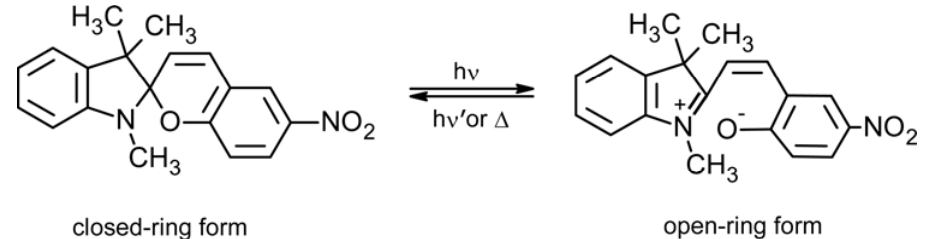
Figure 3. Photo-induced structure change of